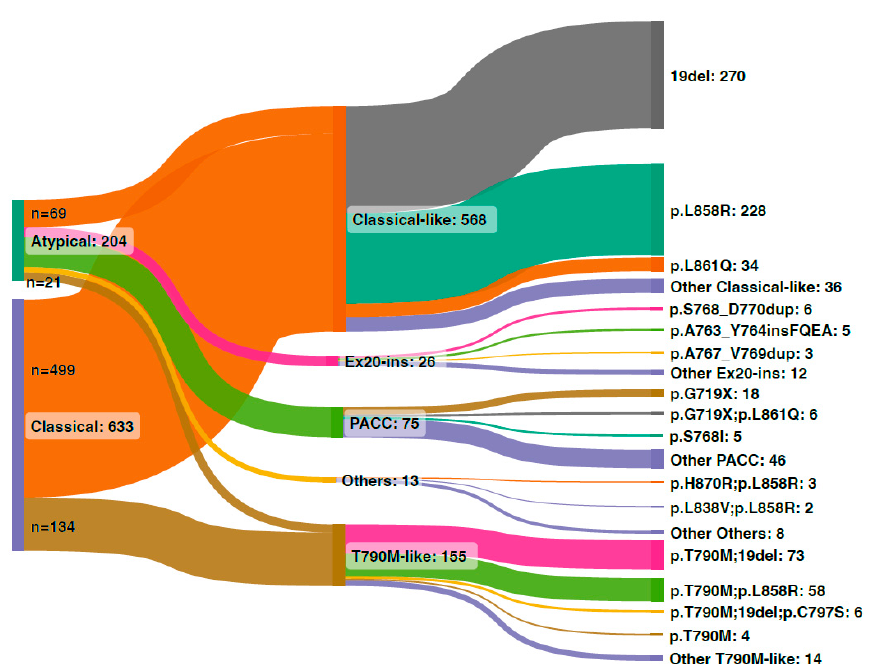
Figure 3. Sankey diagram illustrating the distribution and spectrum of the structural classification of EGFR mutations in the Chinese cohort. The left two nodes represent the numbers of classical and atypical mutations. The middle nodes are the structural classification subgroups. The right nodes represent the individual mutations.